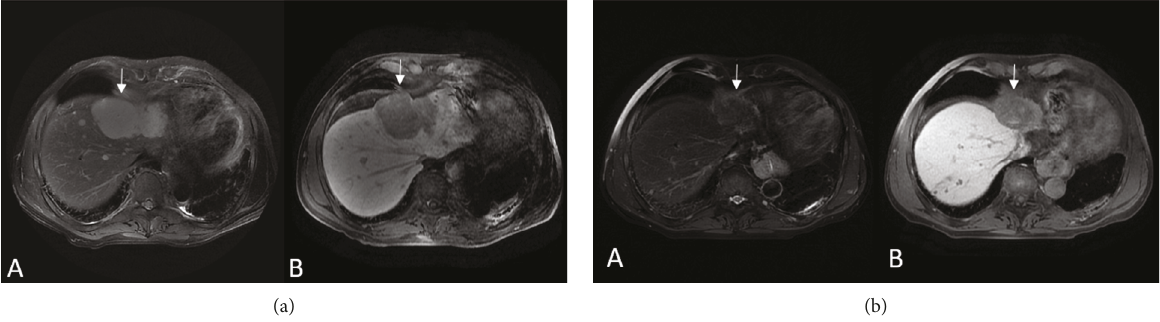
Figure 2: (a) Pretreatment scan (8/22/2016) (MRI). Axial T2 WI (A) and postcontrast (Eovist) Axial T1 WI (B) showing an 11 cm mass in the left liver lobe (arrows) and multiple smaller lesions in both liver lobes. (b) Ongoing treatment (5/2/2018) (MRI). Axial T2 WI (A) and postcontrast (Eovist) Axial T1 WI (B) show the decrease in size of the largest mass in the left liver lobe (arrows) now measuring 4.8 cm with no enhancement. There is a decrease in size and number of the multiple smaller lesions in both liver